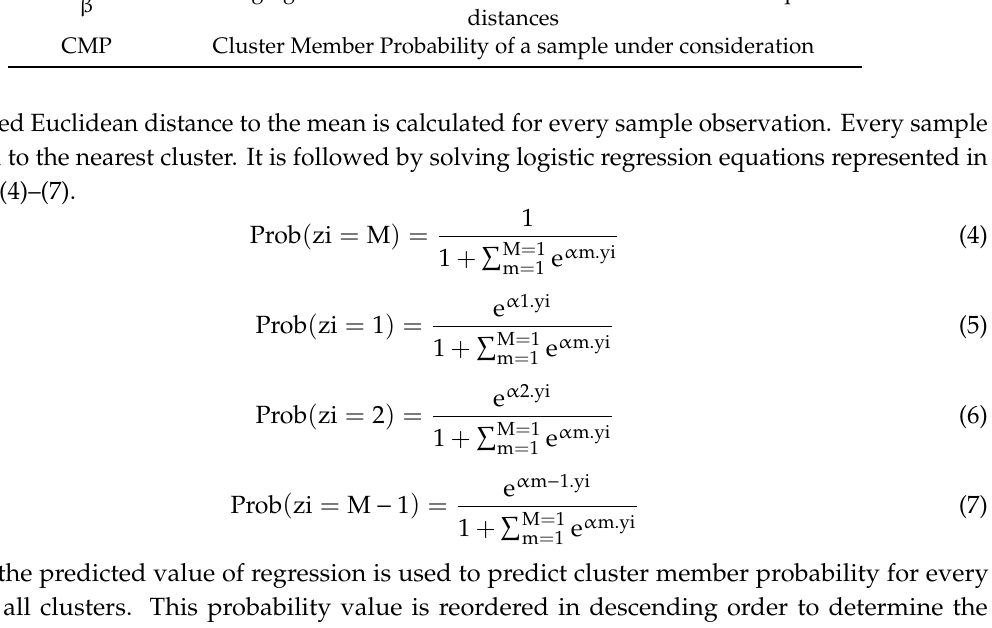
Converging factor for linear di ff erence in cumulative sum of squared distances CMP Cluster Member Probability of a sample under